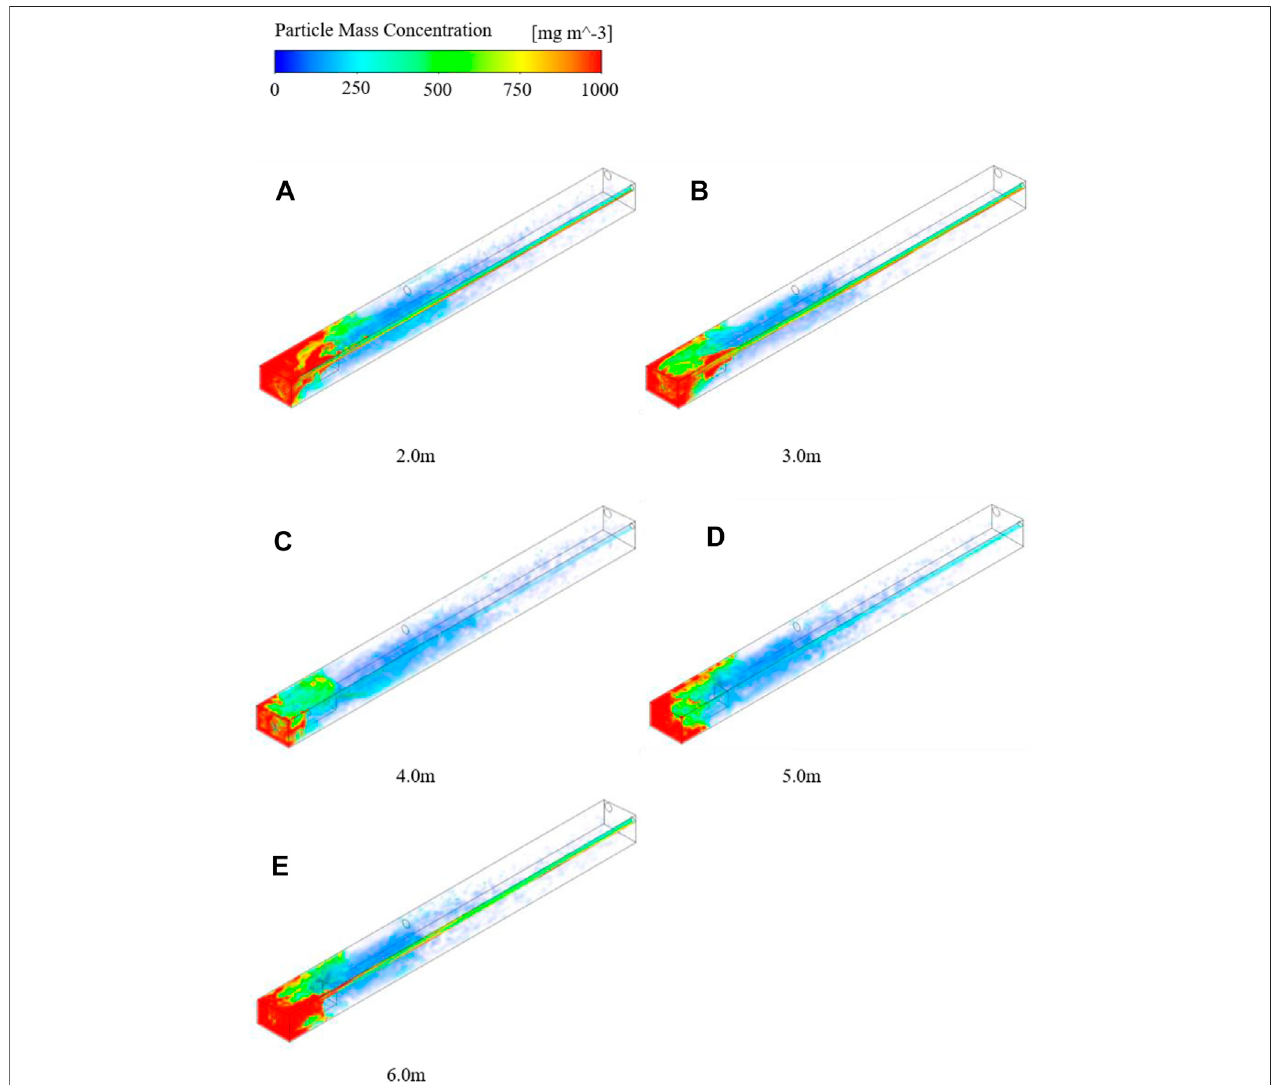
FIGURE 13 | Dust diffusion for different dedusting-air duct distances (roadheader): (A) 2.0 m; (B) 3.0 m; (C) 4.0 m; (D) 5.0 m; (E) 6.0 m.